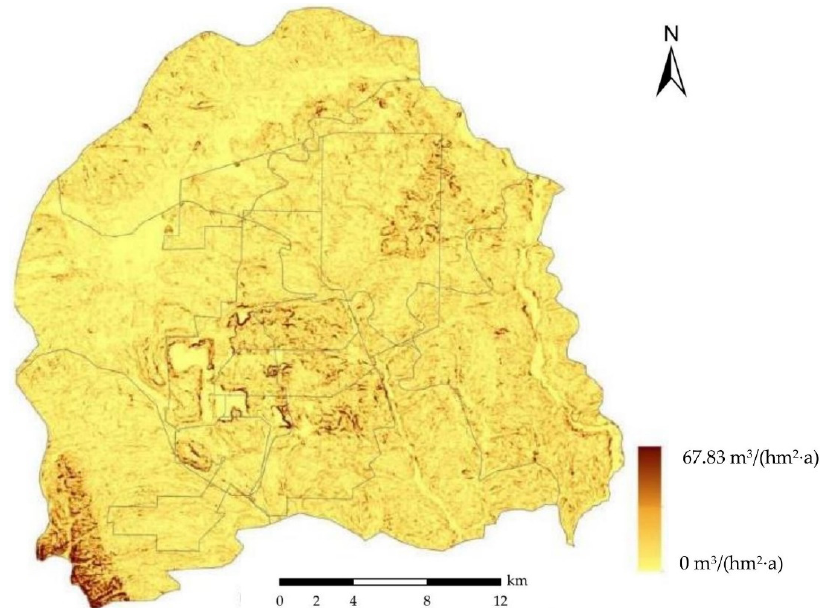
Figure 6. Distribution of SCF in the mine–agriculture–urban compound area.